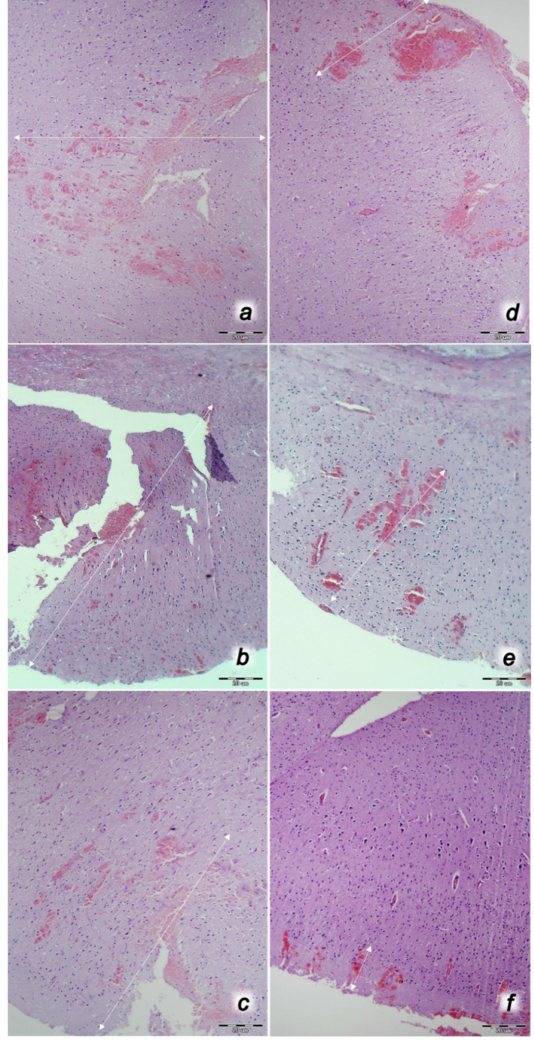
Figure 13. Brain pathology. Intracerebral hemorrhage in the fronto-parietal area. Control ( a – c ); BPC 157 ( d – f ); first lithium application ( a , d ); second lithium application ( b , e ); third lithium application ( c , f ). A marked hemorrhage was found in control lithium-treated rats after each of the lithium administrations affecting larger and deeper areas (grey and white matter). In contrast, BPC 157- treated rats had hemorrhaging located mostly in the grey matter, and smaller in diameter (lesion depth marked with double sided arrow perpendicularly orientated to the brain surface) (HE, magnification × 200) (HE, magnification × 200, scale bar 20 µ